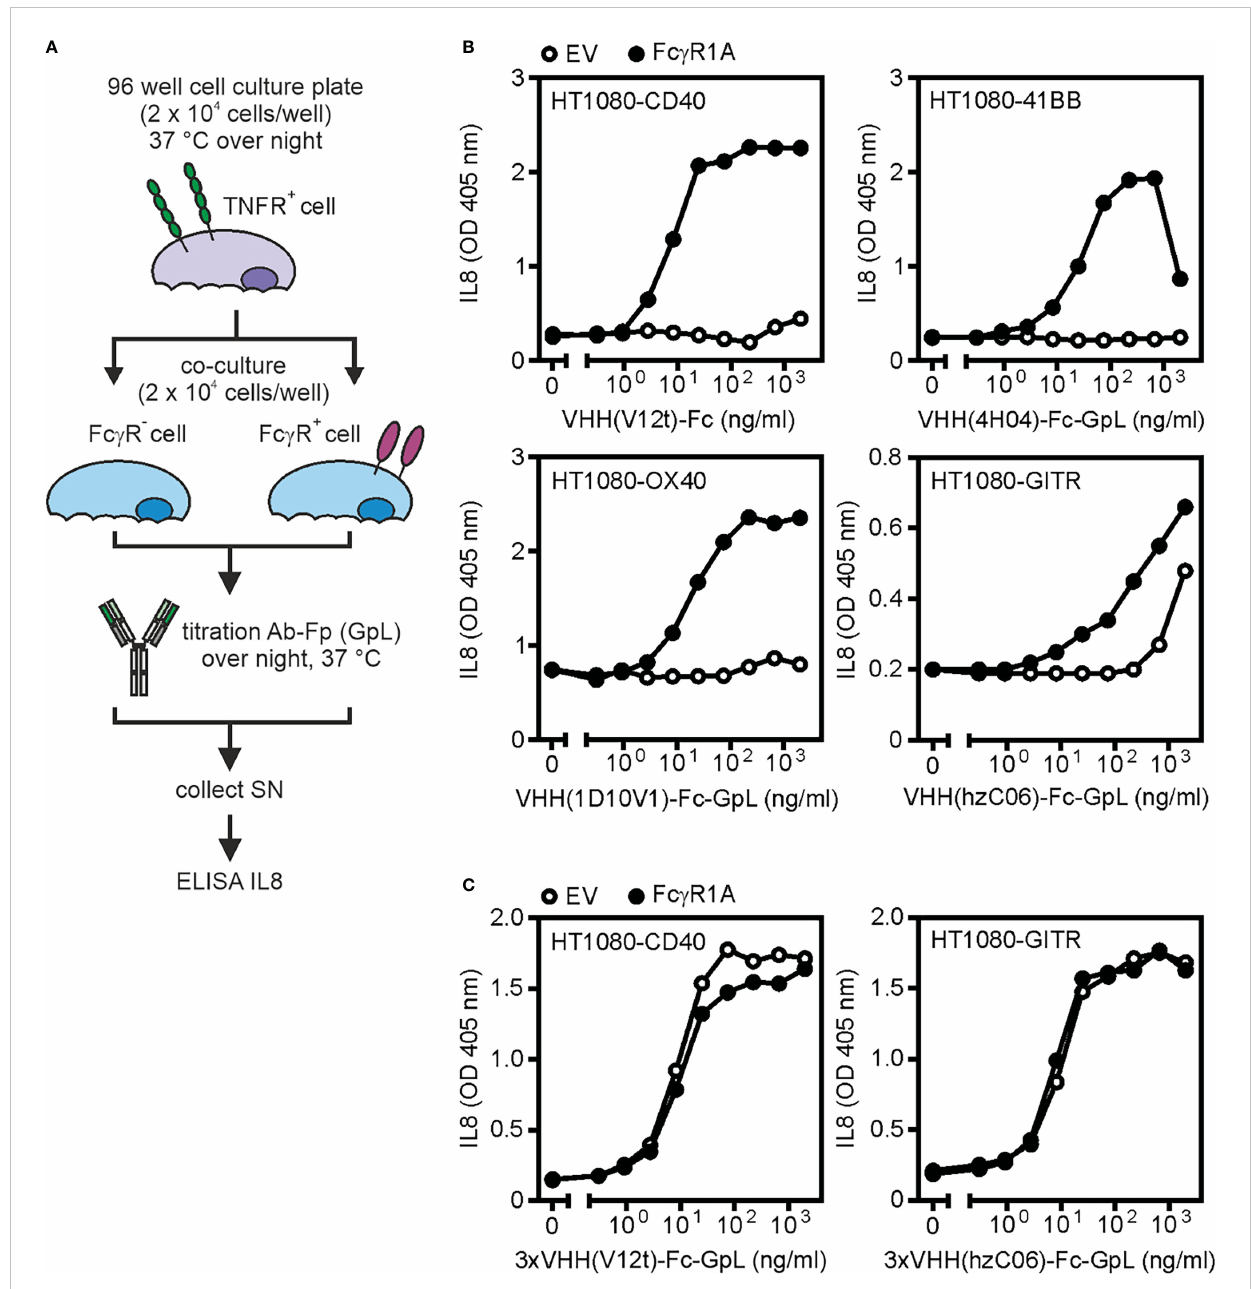
FIGURE 5 Fc g R-dependent and -independent activity of antibodies targeting TNFRs. (A) Process chart of method. (B, C) The indicated HT1080-transfectants have been treated as indicated with the TNFR-speci fi c VHH-Fc (B) or VHH(3x)-Fc (C) fusion proteins VHH(V12t)-Fc (CD40-speci fi c), VHH(4H04)-Fc- GpL (41BB-speci fi c), VHH(1D10V1)-Fc-GpL (OX40-speci fi c), VHH(hzC06)-Fc-GpL (GITR-speci fi c); 3xVHH(V12t)-Fc-GpL (CD40-speci fi c) and 3xVHH (hzC06)-Fc-GpL (GITR-speci fi c) along with HEK293 cells transfected with empty vector (EV) or an expression plasmid encoding Fc g R1A. Next